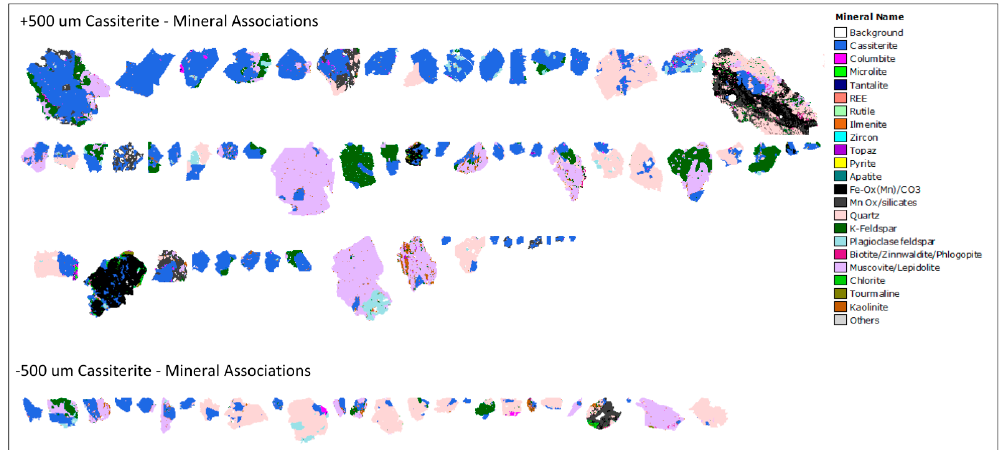
Figure 9. QEMSCAN false colour image of Cassiterite minerals associations (Legend is the same as Figure 8).